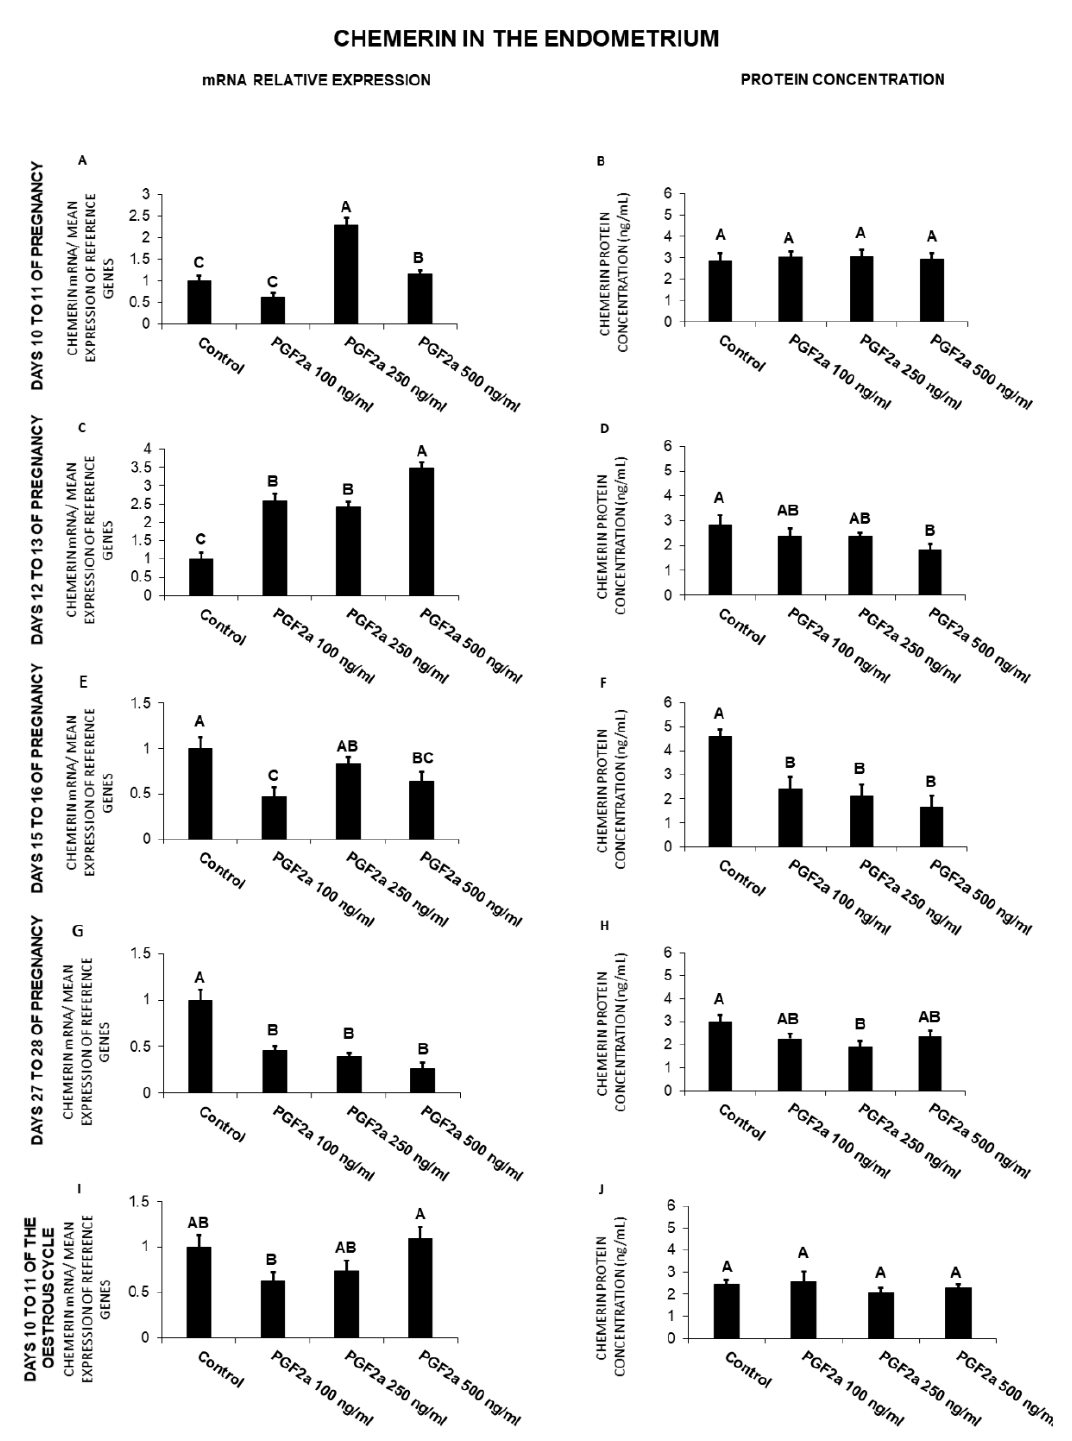
Figure 5. The influence of prostaglandin F 2 α (PGF 2 α ; 100, 250, 500 ng / mL) on chemerin mRNA expression ( A , C , E , G , I ) and chemerin protein secretion ( B , D , F , H , J ) in the porcine endometrial tissue explants on days 10 to 11, 12 to 13, 15 to 16, and 27 to 28 of the pregnancy, and on days 10 to 11 of the estrous cycle. The gene expression was determined by quantitative real-time PCR. The proteins secretion was determined by an ELISA test. Results are reported as the means ± S.E.M. ( n = 5). Bars with different superscripts differ ( p < 0.05).